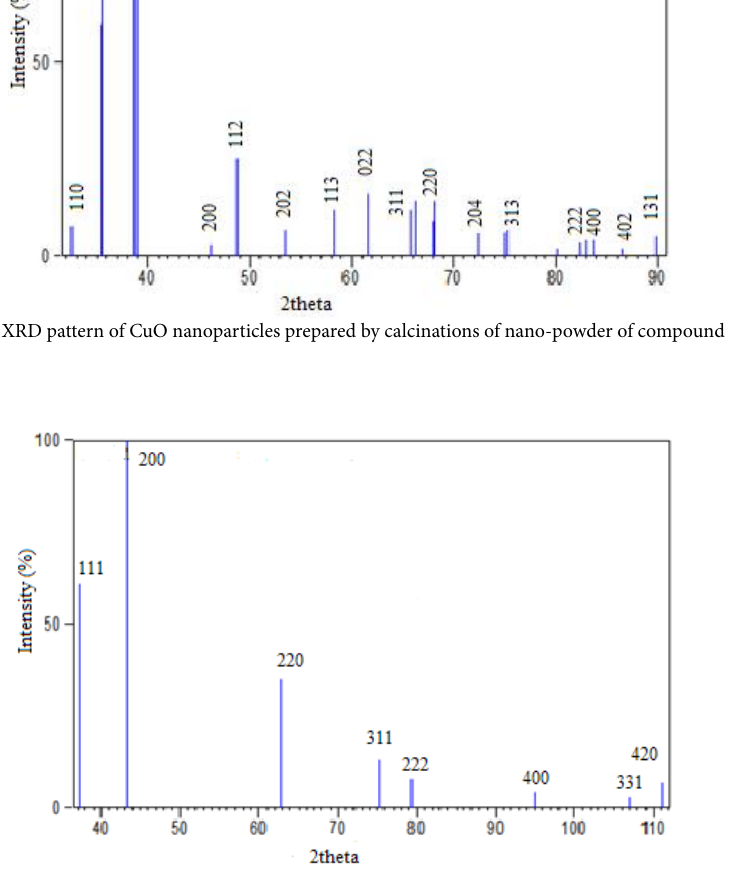
Fig. 10. XRD pattern of NiO nano-particles prepared by calcinations of nano-powder of compound 2